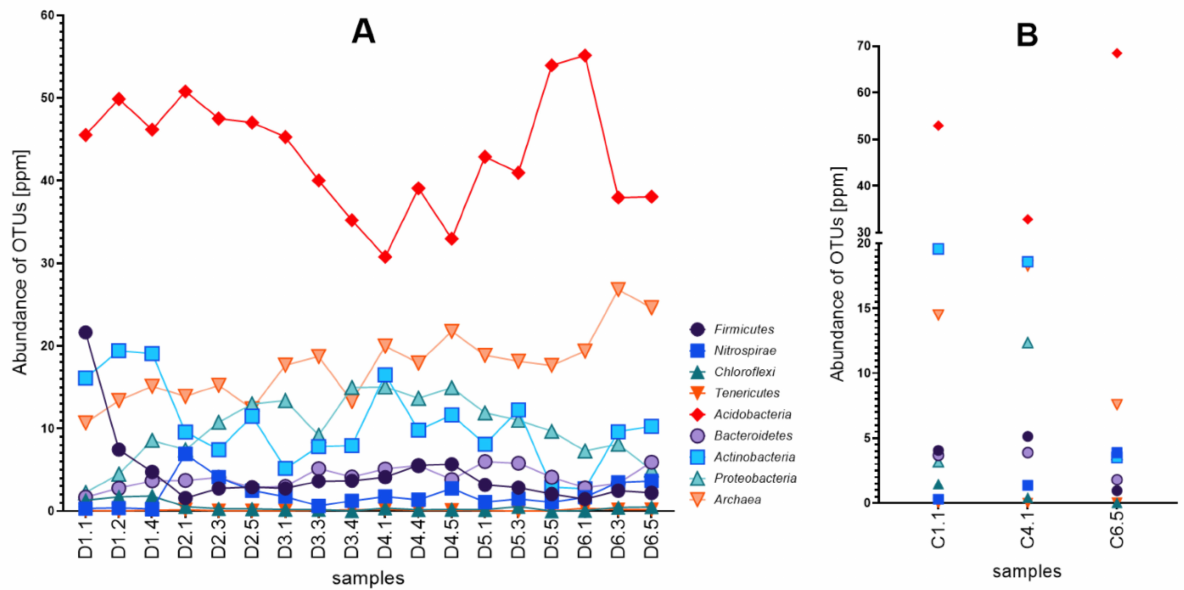
Figure 3. Abundance of OTUs [ppm] characteristic of the dominant microbial phyla in the process ( A ) and control bioreactors ( B ). D-dose ID, C-control